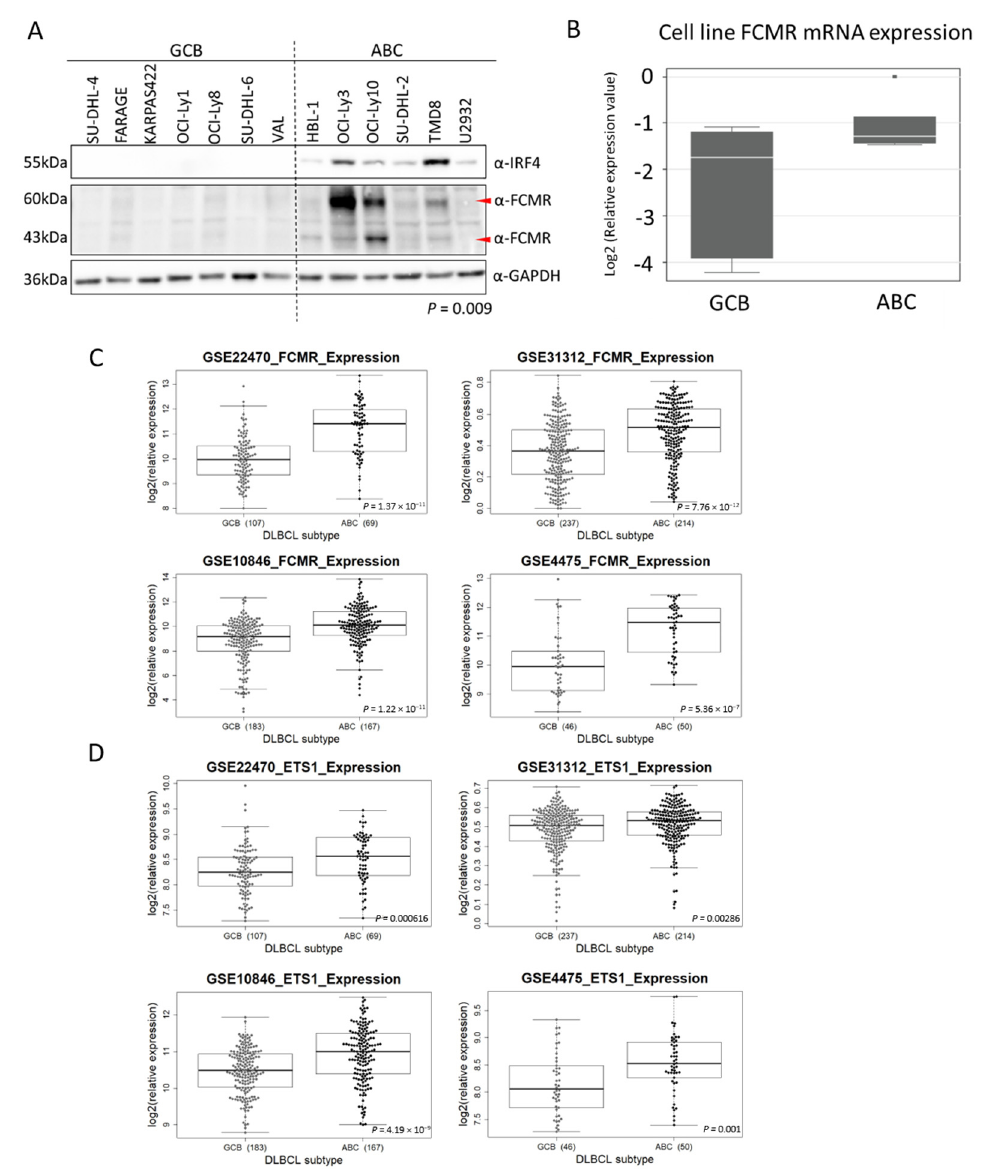
Figure 4. FCMR expression in clinical specimens and DLBCL cell lines. ( A ) Protein expression of FCMR in seven GCB-DLBCL and six ABC-DLBCL cell lines. FCMR (FAIM3) protein expression was significantly associated with ABC-DLBCL cell lines (Chi-square p = 0.009). IRF4 expression was only expected in ABC-DLBCL cell lines. The α -GAPDH was used as loading control, n = 3. ( B ) Quantitative real-time PCR analysis of FCMR expression in seven GCB-DLBCL and six ABC-DLBCL cell lines. Solid white lines in box-plots represent the median FCMR expression per each subset. ( C , D ) Di ff erential expression of FCMR or ETS1 in four datasets comparing GCB-DLBCL to ABC-DLBCL. Expression values are Log2 transformed. Significance calculated with the Wilcoxon rank sum test. Uncropped blots See Figure